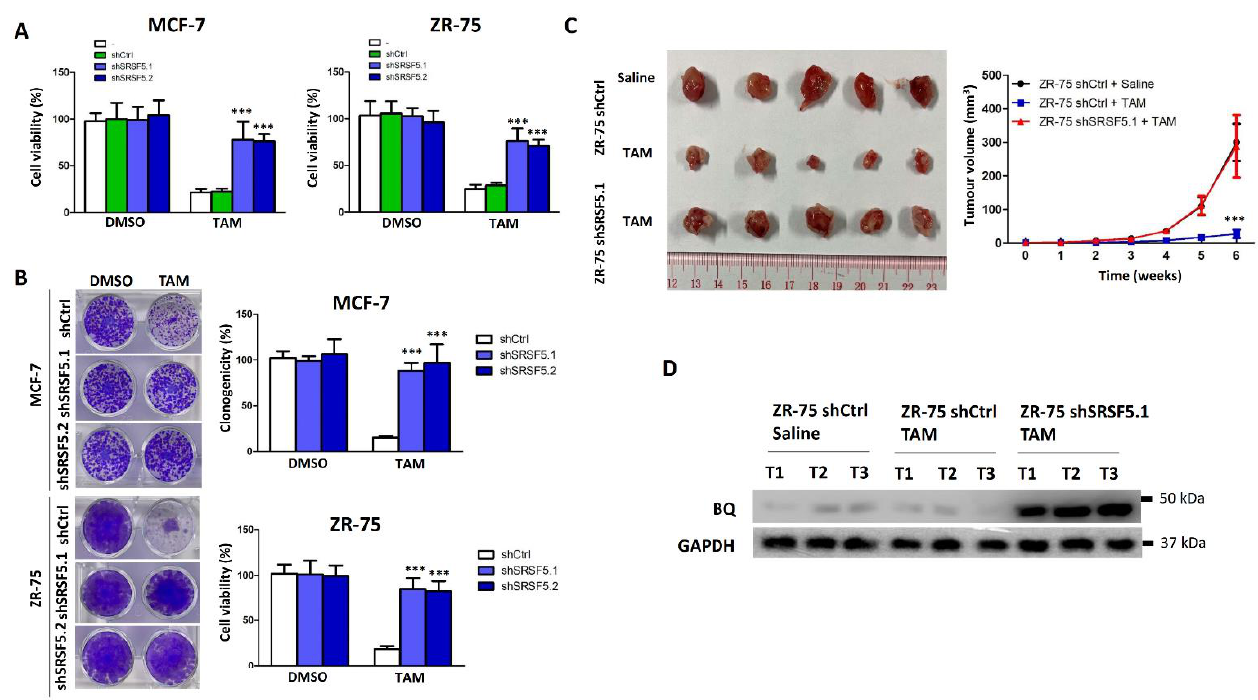
Figure 3. Knockdown of SRSR5 could induce tamoxifen (TAM) resistance. ( A ) Knockdown of SRSF5 could make MCF-7 and ZR-75 become TAM-resistant. The cells were treated with 5 μM of TAM, and a cell viability assay was conducted after 96 h of the treatment. ( B ) Results of the clonogenic assay. The cells were treated with 5 μM of TAM for 21 days. Results are shown as mean ± SD from termine the statistical significance between shCtrl and shSRSF5.1 or shSRSF5.2 groups. Clonogenic-